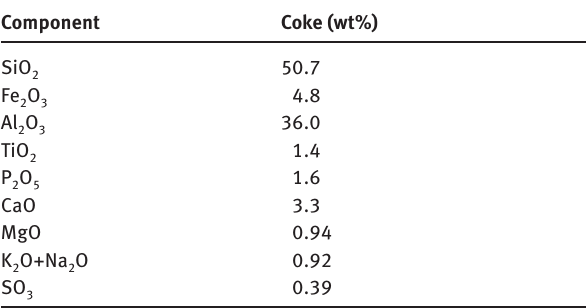
Fig. 2: Composite pellet (of Al 2 O 3 + PP) utilized for thermal decomposition of PP at 1500 °C